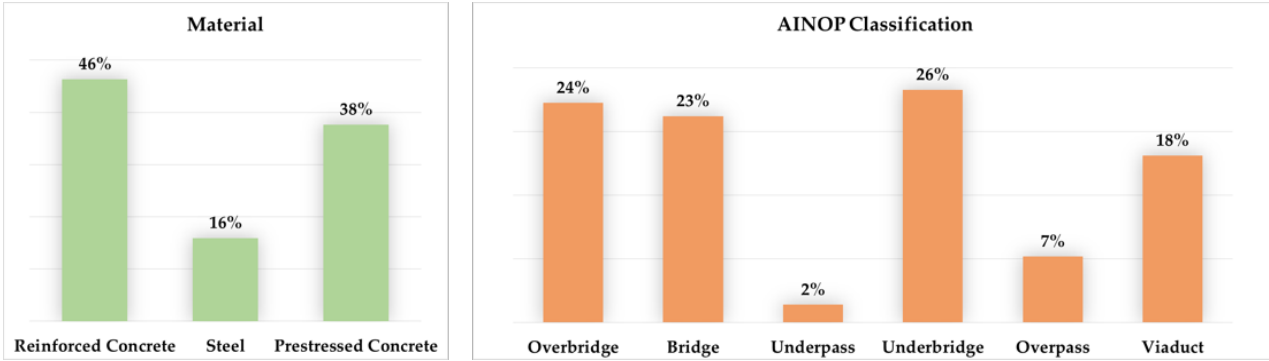
Figure 3. Statistics on the material ( left ) and AINOP classification ( right ) of A3 bridges and viaducts.